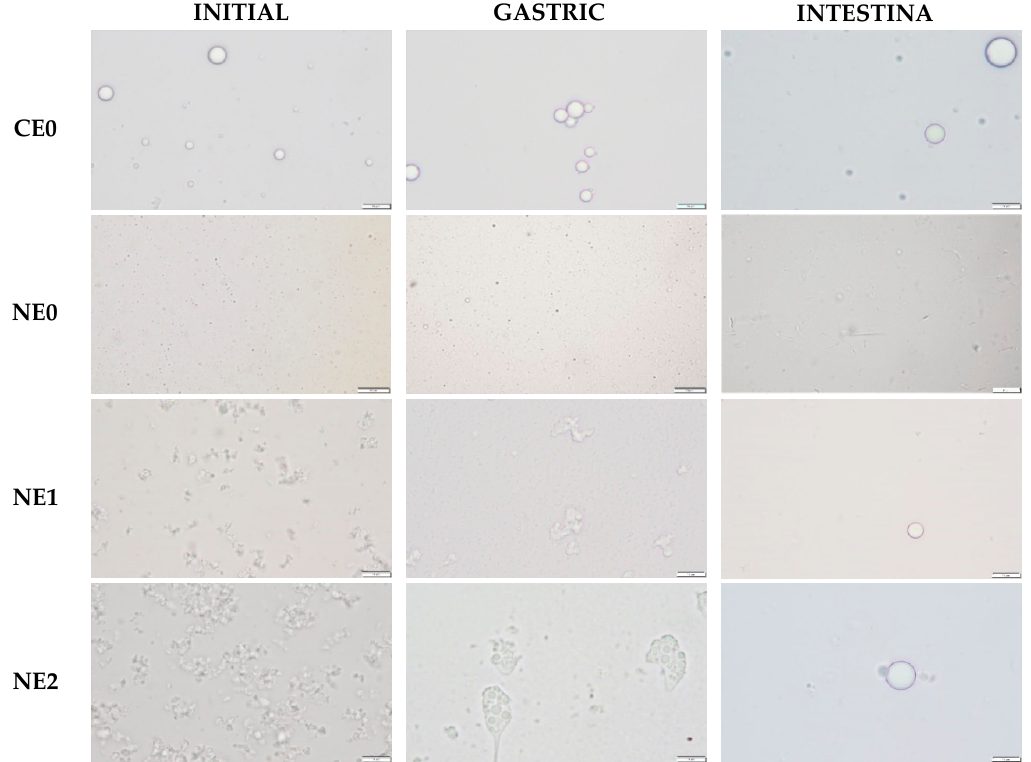
Figure 6. Images of coarse emulsion and nanoemulsions with different pectin concentrations (0%, 1%, and 2%) at different phases of the in vitro digestion. CE0, coarse emulsion without pectin; NE0, nanoemulsion without pectin; NE1, nanoemulsion with 1% of pectin; NE2, nanoemulsion with 2% of pectin. Scale bars were 10 µm long.